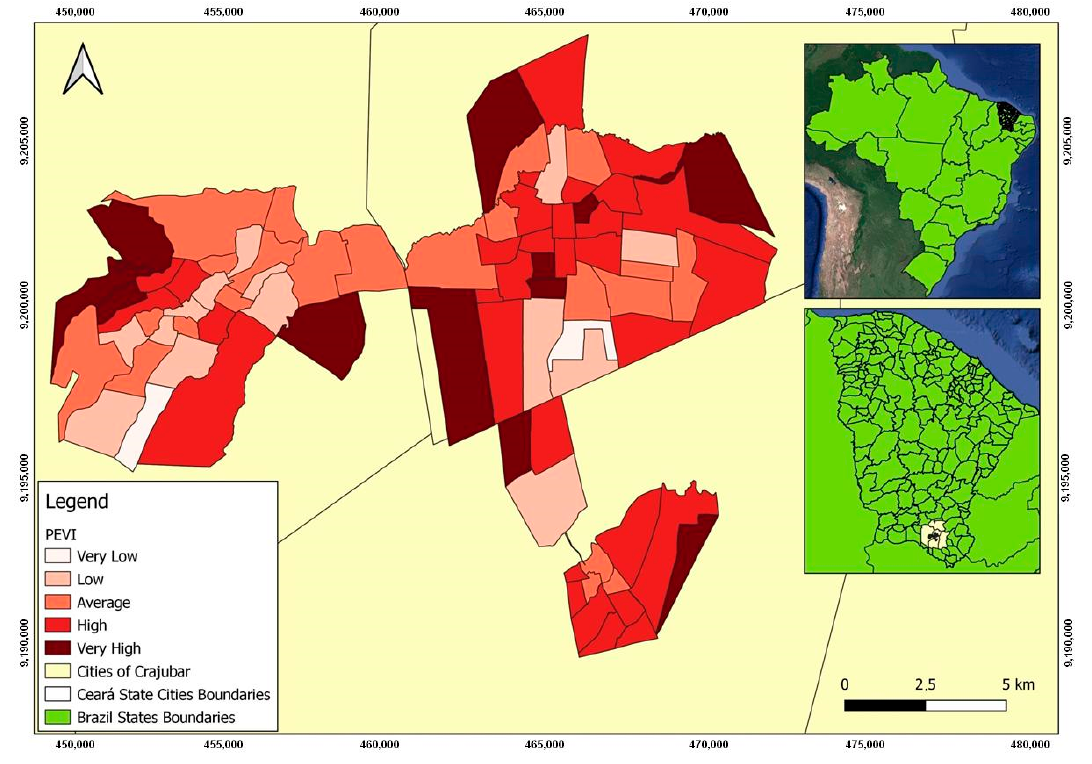
Figure 2. Distribution map of the Potential Epidemic Vulnerability Index in the urban area of Crajubar, northeastern Brazil.